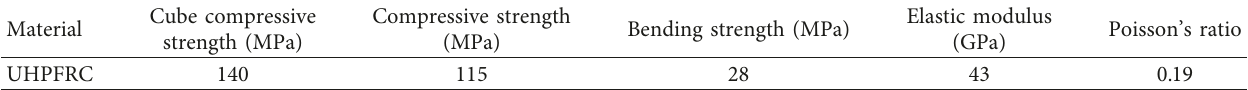
Table 2: Measured mechanical properties of UHPFRC.